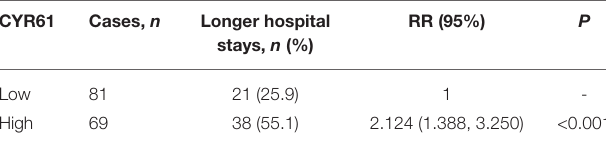
FIGURE 4 | subjects. (C) Serum MCP-1 was compared among control subjects with different levels of CYR61. (F) Correlation analysis between serum CYR61 and MCP-1. (G,J) Association between serum CYR61 and TNF- α was analyzed among all subjects. (G) Serum TNF- α was compared among subjects with different levels of CYR61. (J) Correlation analysis between serum CYR61 and TNF- α . (H,K) Association between serum CYR61 and TNF- α was analyzed among COPD patients. (H) Serum TNF- α was compared among COPD patients with different levels of CYR61. (K) Correlation analysis between serum CYR61 and TNF- α . (I,L) Association between serum CYR61 and TNF- α was analyzed among control subjects. (I) Serum TNF- α was compared among control subjects with different levels of CYR61. (L) Correlation analysis between serum CYR61 and TNF- α . * P < 0.05, ** P < 0.01.